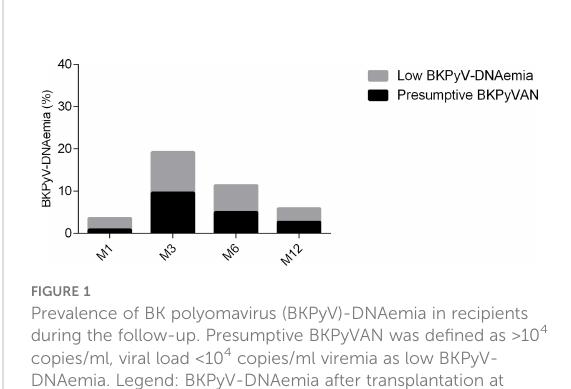
FIGURE 1 Prevalence of BK polyomavirus (BKPyV)-DNAemia in recipients during the follow-up. Presumptive BKPyVAN was de fi ned as >10 4 copies/ml, viral load <10 4 copies/ml viremia as low BKPyV- DNAemia. Legend: BKPyV-DNAemia after transplantation at month 1 (M1), 3 (M3), 6 (M6), and 12